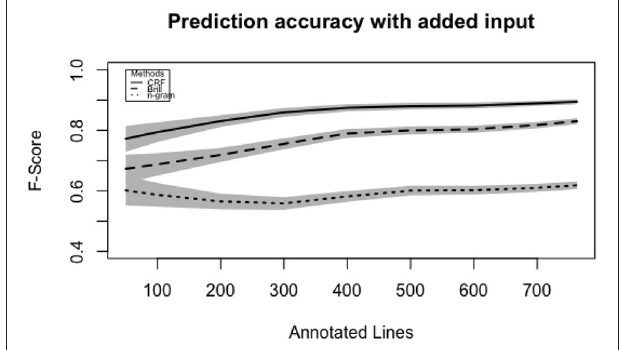
FIGURE 2 | Tagging F-score with added